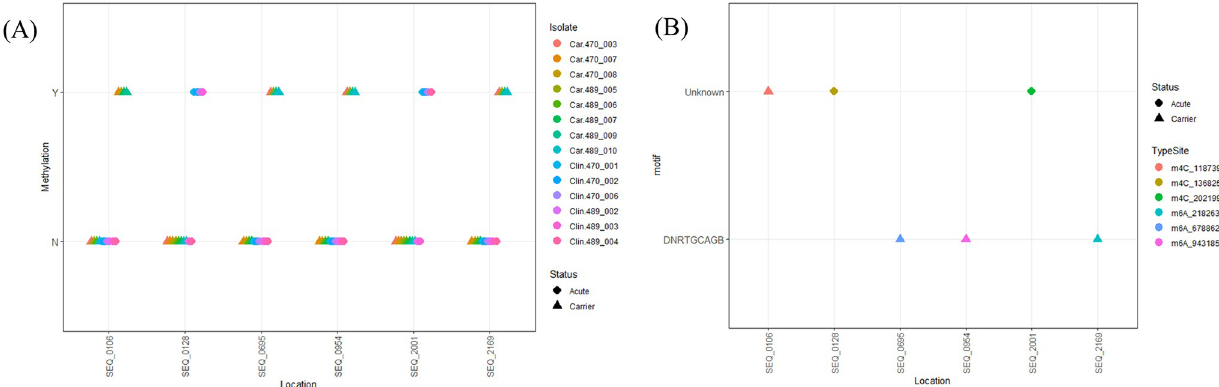
Fig 3. Methylation locations and motifs from SEE isolates from Sweden. (A) Depiction of whether methylation occurred at a specified genomic location. Genomic locations are indicated along the x-axis, and whether methylation occurred is indicated on the y-axis as yes (Y) or no (N), by SEE isolates. Circles represent acute clinical isolates, and triangles represent inapparent carrier isolates. (B) Sites of methylation (x-axis), by the methylation motif (y-axis). The type of methylation and exact position in the genome are indicated by different colors. Circles represent acute clinical isolates, and triangles represent inapparent carrier isolates.